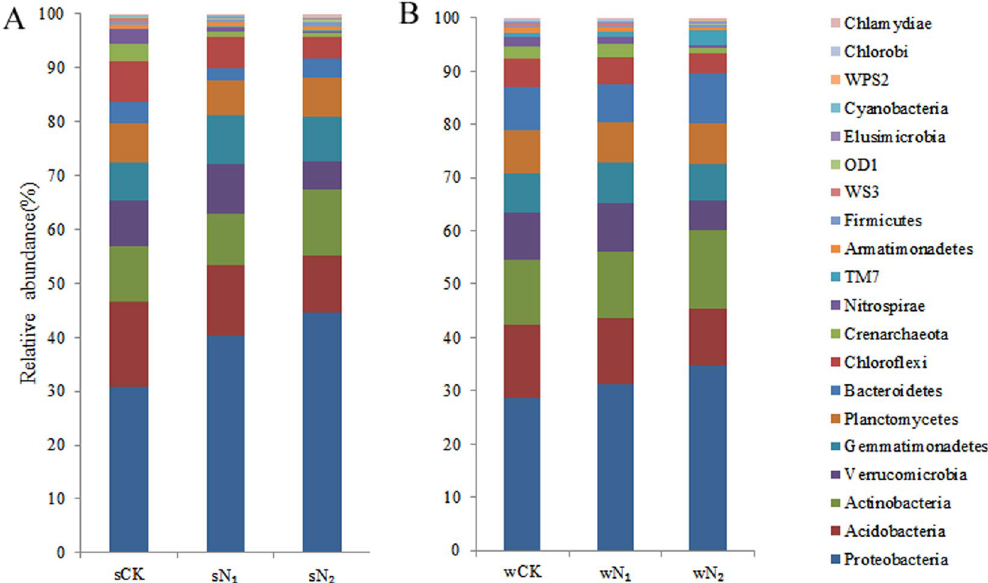
Figure 3. Bacterial compositions of different N fertilizer regimes. Each bar represents the average relative abundance of each bacterial taxon within a group. The top 20 abundant phyla are shown (relative abundance > 0.01%). sCK, sN 1 and sN 2 indicate different N treatments in the soybean season; wCK, wN 1 and wN 2 indicate different N treatments in the wheat